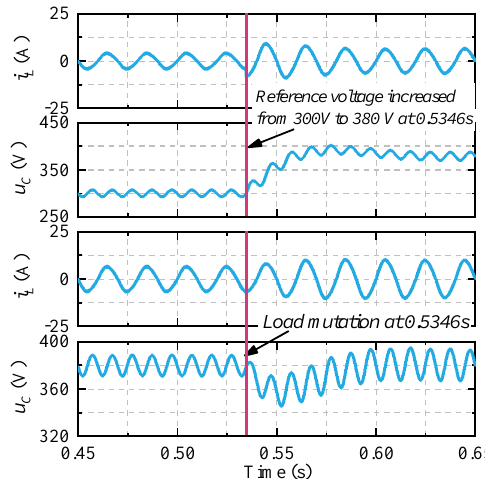
Figure 6. Input current and capacitor voltage during the time of load sudden change and reference voltage change.